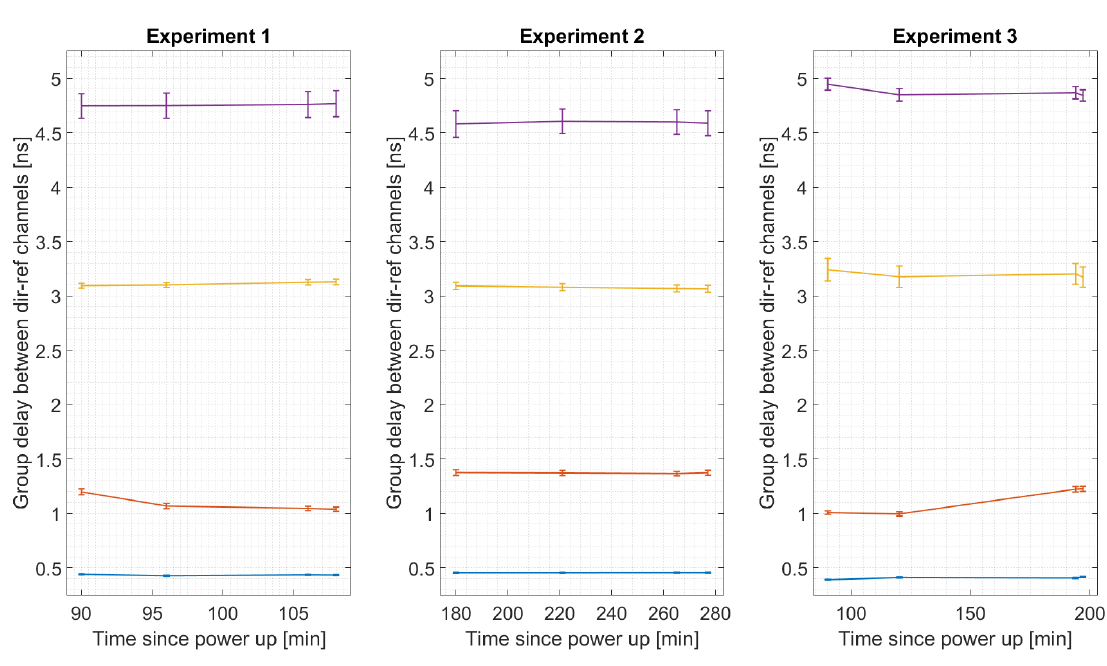
Figure 16. Estimated group delay between the direct and reflected RF channels for the four different USRPs during three sets of experiments. The lines show the drift between the estimations, and the markers are error